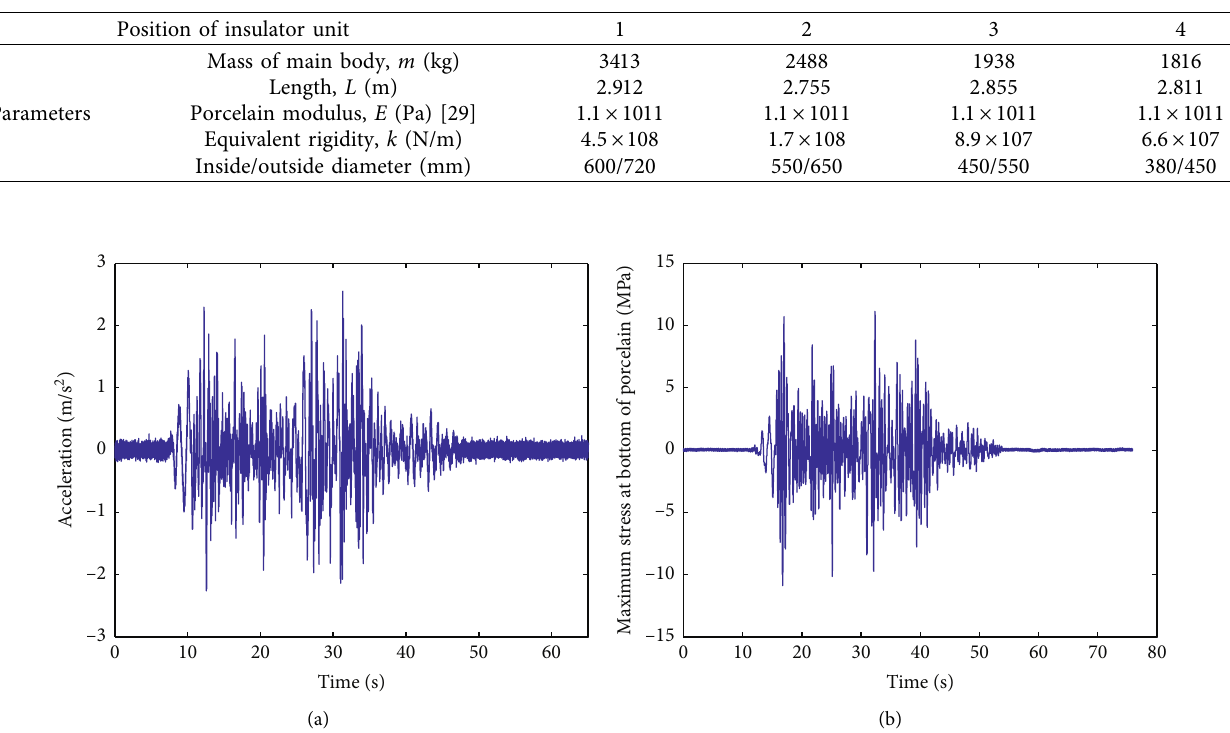
Figure 9: The waveform of shaking table test results (0.15g). (a) Input acceleration time history (b) Stress responses at the